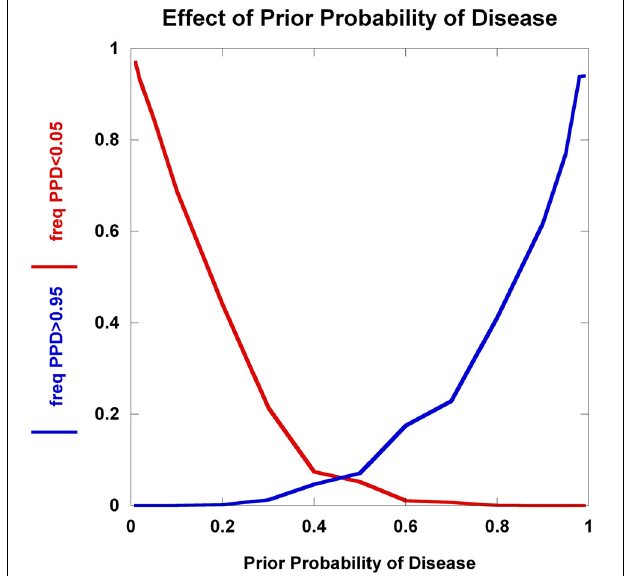
FIGURE 5 | Effect of prior probability. The frequency of multilocus genotype combinations exceeding the C 1 and C 2 thresholds for posterior probabilities of disease (PPD) (set at 0.05 and 0.95, respectively) are presented as a function of the prior probability of disease. 100 predisposing SNPs were used in the model, each having a predisposing genotype frequency of 5% in controls and relative risk of